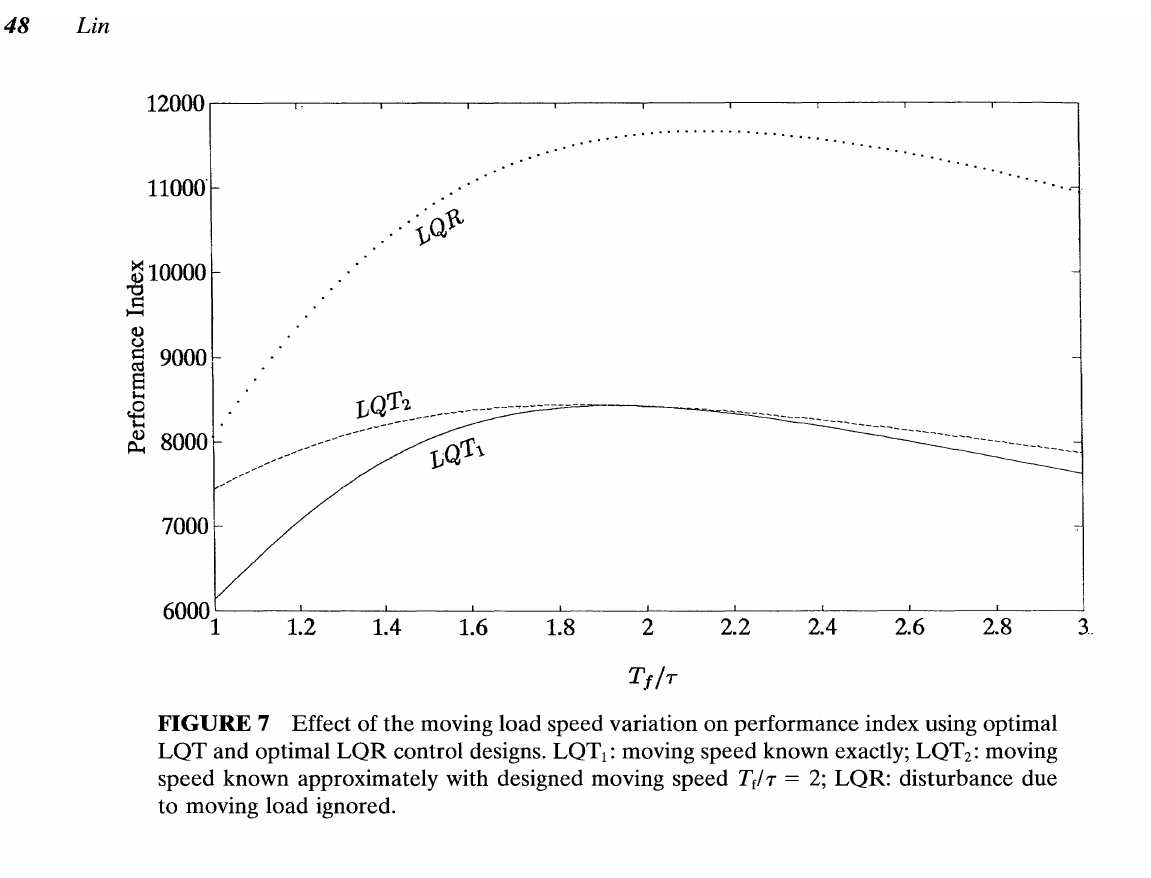
FIGURE 7 Effect of the moving load speed variation on performance index using optimal LOT and optimal LOR control designs. LOTI: moving speed known exactly; LOT 2: moving speed known approximately with designed moving speed Tfl T = 2; LOR: disturbance due to moving load